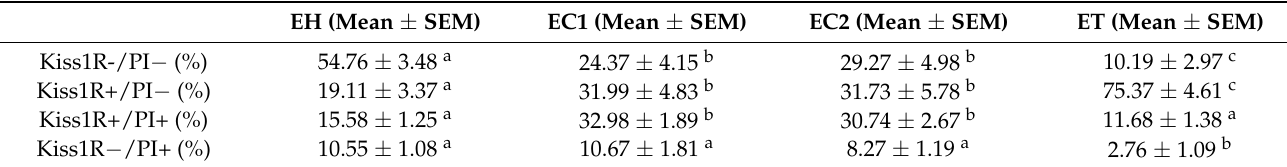
Table 1. Sperm subpopulations (mean ± standard error of the mean—SEM) on the basis of plasma membrane integrity (sperm plasma membrane damage—PI+) and sperm surface Kiss1R expression (positivity to Anti-Kiss1R antibody— Kiss1R+) in the different epididymal tracts of the dog.